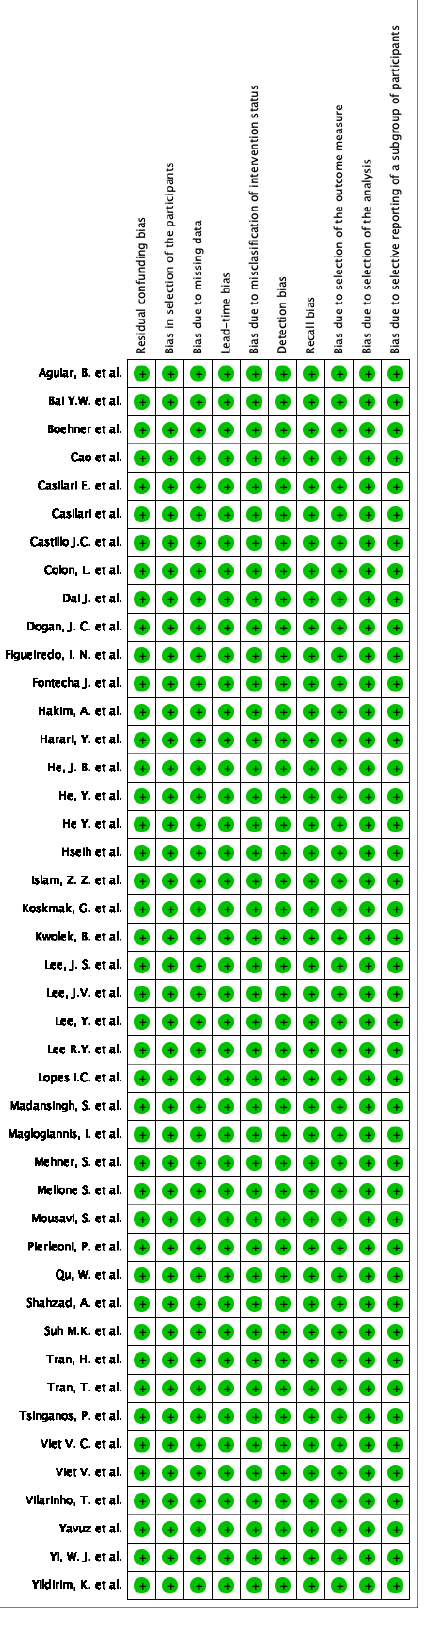
Figure 3. Risk of bias summary: review authors’ judgments about each risk of bias item for each included